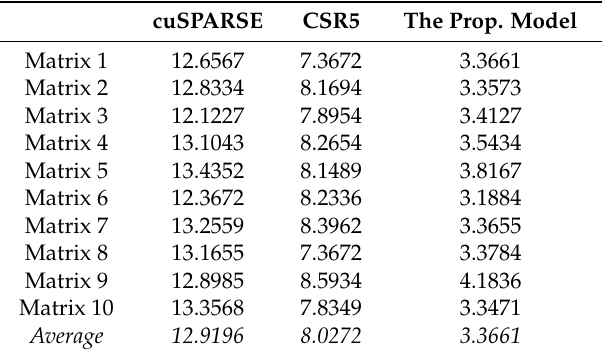
Table 9. Performance with a block size of